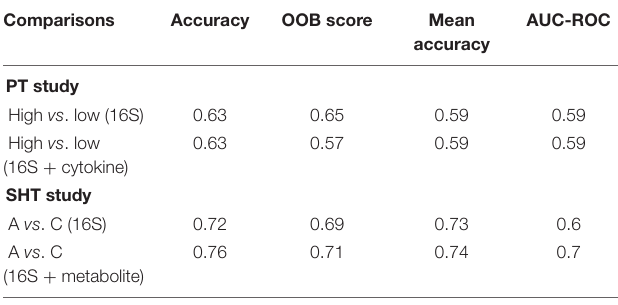
TABLE 4 | Results of random forest analysis with single and combined multiomics.